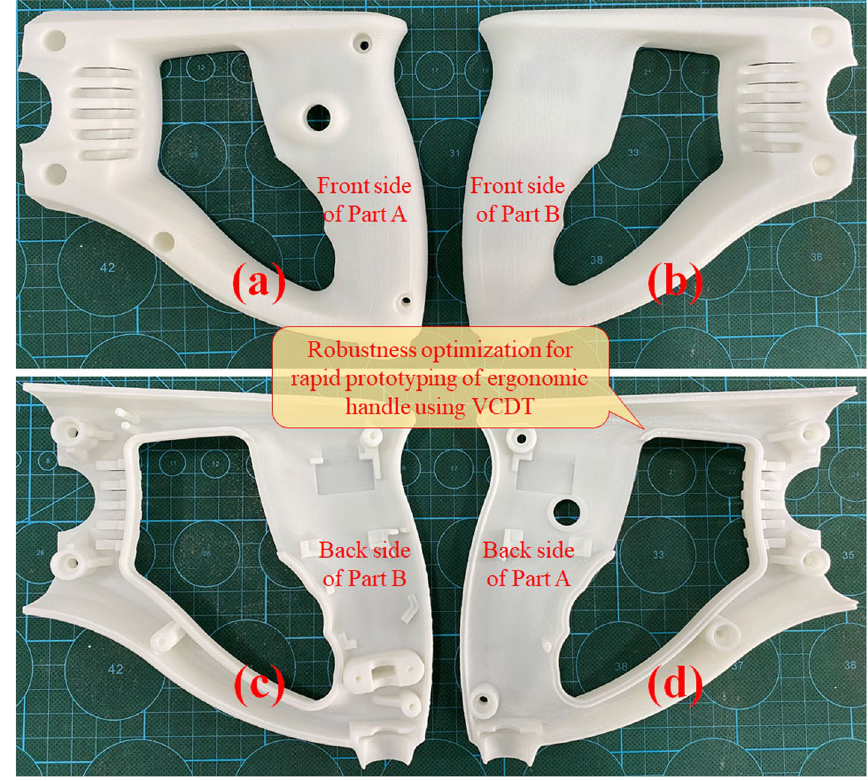
Fig. 14 Fabricated ergonomic heavy-duty half handles where a , b , c , and d illustrate distinct parallel orthographic